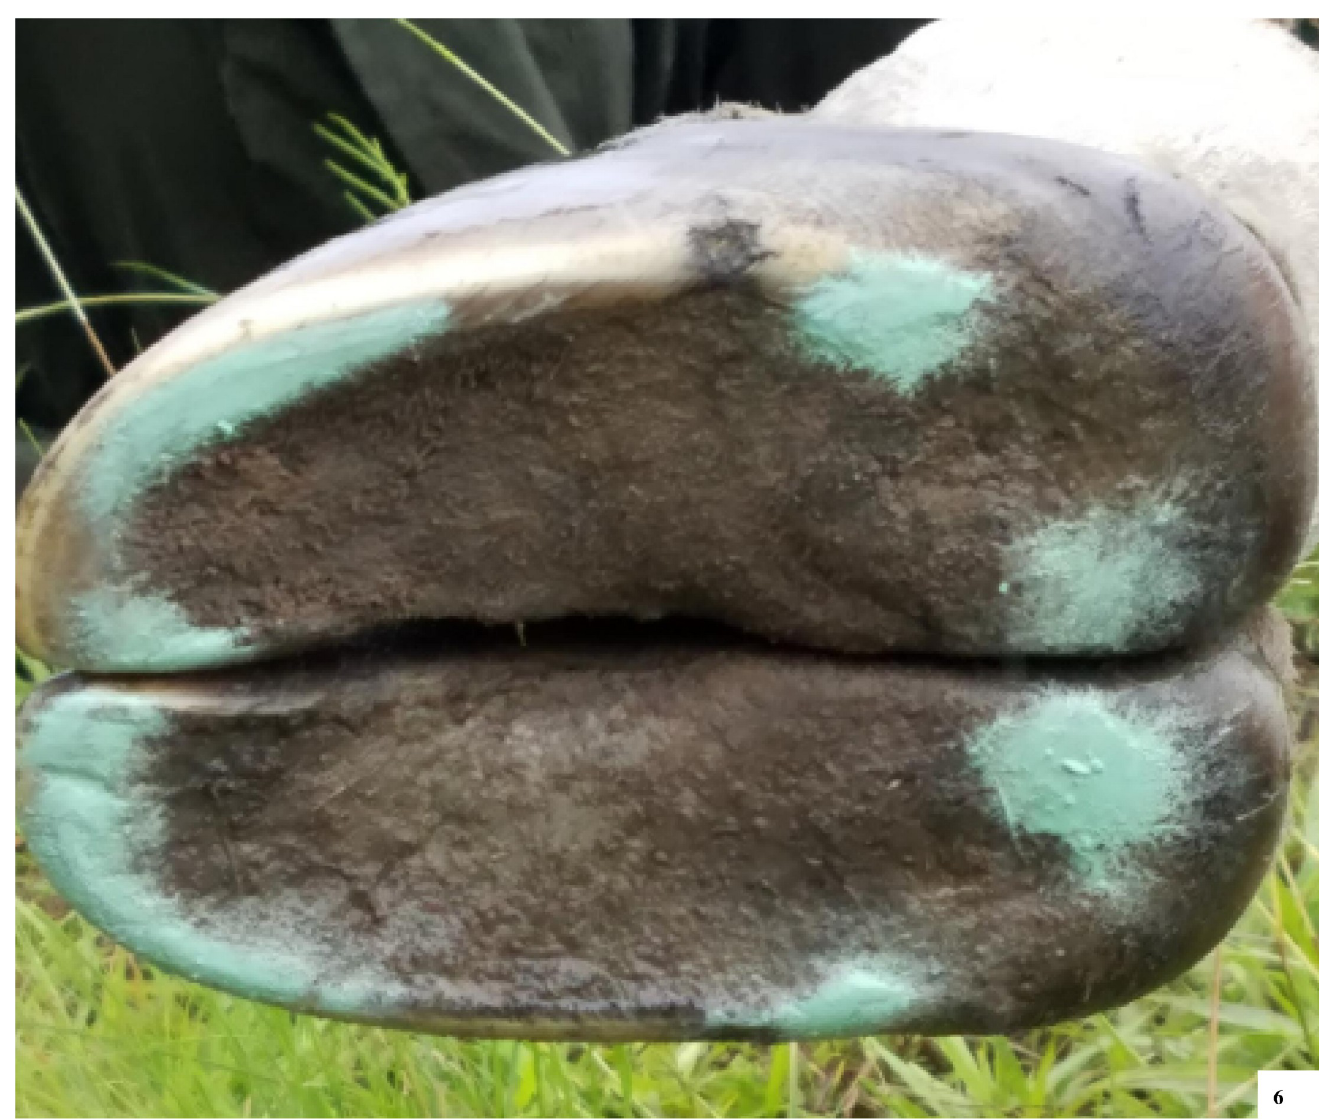
Fig 6. The solar surface of the giraffe’s foot is concave with hoof ground contact points around the periphery of the foot including the hoof wall, heel, and parts of the sole. Paint marks the most prominent aspects of the sole with the giraffe in lateral recumbency, with most paint on the hoof wall and heel.